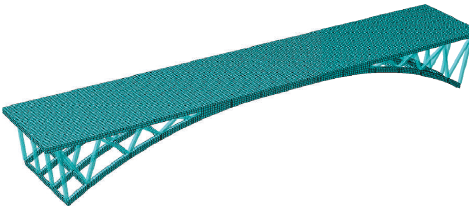
Figure 12: Finite element model of the